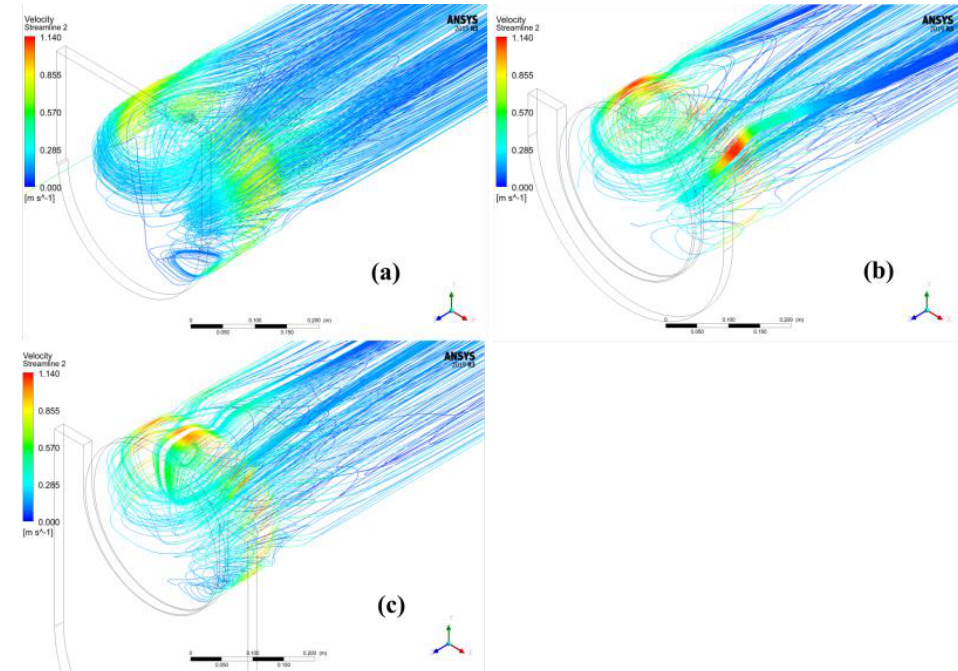
Figure 13. Streamlines of the flow inside the pipe at the end of the valve closure for the different valve modelling method: ( a ) immersed solid; ( b ) dynamic mesh; ( c ) sliding mesh.